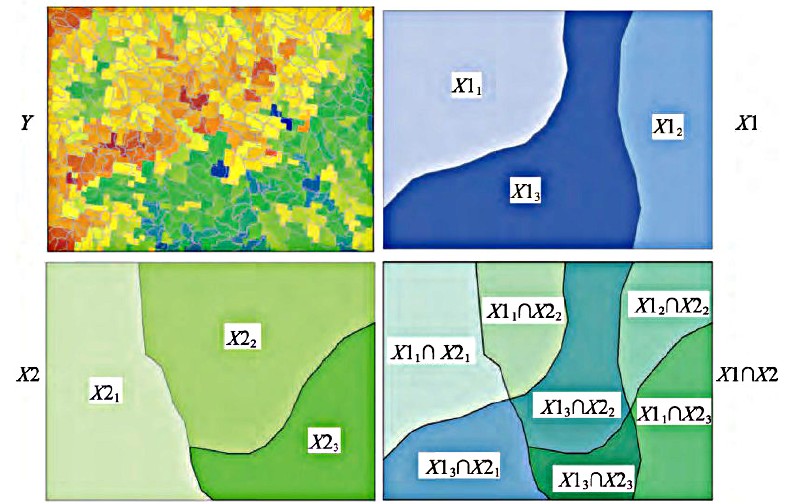
Figure 5. Interaction detector. Y is the dependent variable. X 1 and X 2 are evaluation factors. Overlay the two layers X 1 and X 2 to get the new layer X 1 (cid:84) X 2.